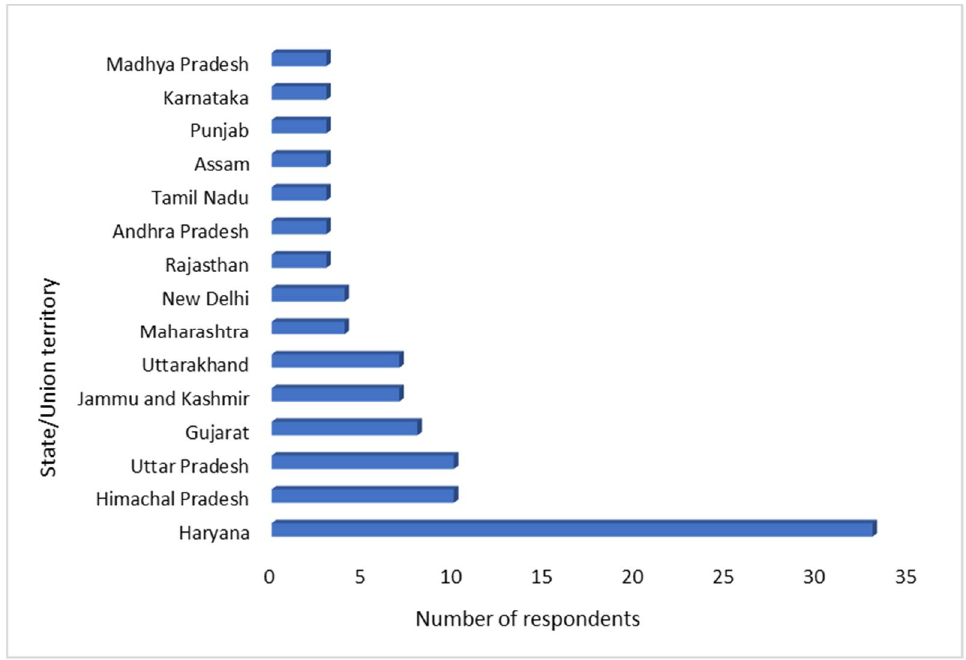
Figure 1. Distribution of respondents according to the states/union territories of India. Table 1. Descriptive statistics of the responses provided by the respondents ( n = 104).